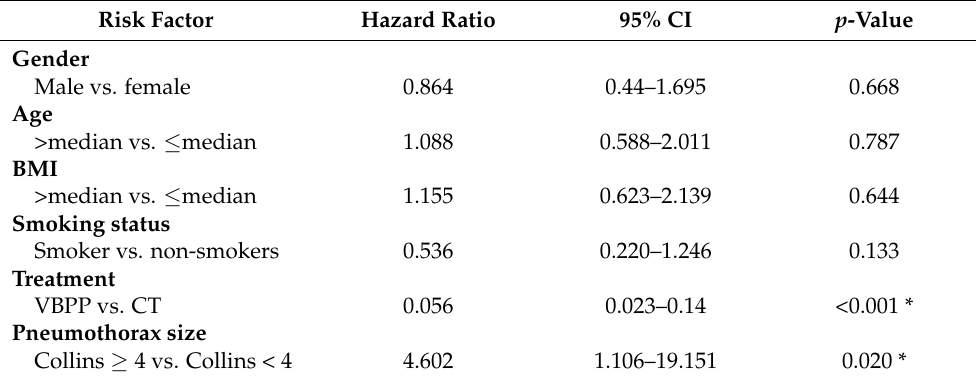
Table 3. Univariate analysis of potential risk factors for recurrence of